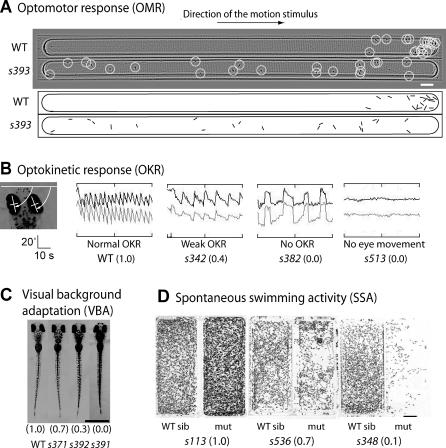
Behavioral Screening Assays(A) OMR. WT larvae in the racetrack reflexively swim in the same direction as a moving stimulus (top). Mutant larvae (for example, dlns393) with an OMR index of 0 fail to respond (bottom). A contrast-enhanced image outlining the fish is shown in the lower image. In this experiment, WT fish larvae were driven all the way to the right end of the racetrack, which differs slightly from our screening assay [16].(B) OKR. Eye positions (angles shown by white arrows, far left image) were plotted over time during optokinetic stimulation in one direction. The OKR has a sawtooth profile, consisting of alternating quick and slow phases. OKR mutants show slowed eye movements (for example, nebos342), absence of the OKR (lims382), or no eye movements (flans513). Corresponding OKR indices are given in parentheses.(C) VBA. WT (VBA index = 1) shows fully contracted melanophores in bright illumination. Mutants (edpos371, ymjs392, and amjs391) show three gradations of darker pigmentation, due to enhanced melanin dispersal. Scale bar is 1 mm.(D) SSA. Movies of six fish per rectangular well, taken at 0.5 frame per second for 20 min, were subtracted frame by frame and projected into a single image to show the locomotor behavior over time. Blind mutants, such as mtis113 (OKR and OMR indices = 0), may show normal spontaneous activity (SSA index = 1). The mti mutants are also darker (VBA = 0.3), resulting in a higher-contrast image than WT. The walks536 mutants (OKR = 0.8; OMR = 0) show less activity, with some circling (SSA = 0.7), which could explain part of their OMR defect. In beats348 mutants, locomotion is severely compromised (SSA = 0.1). SSA-defective mutants were not systematically kept.